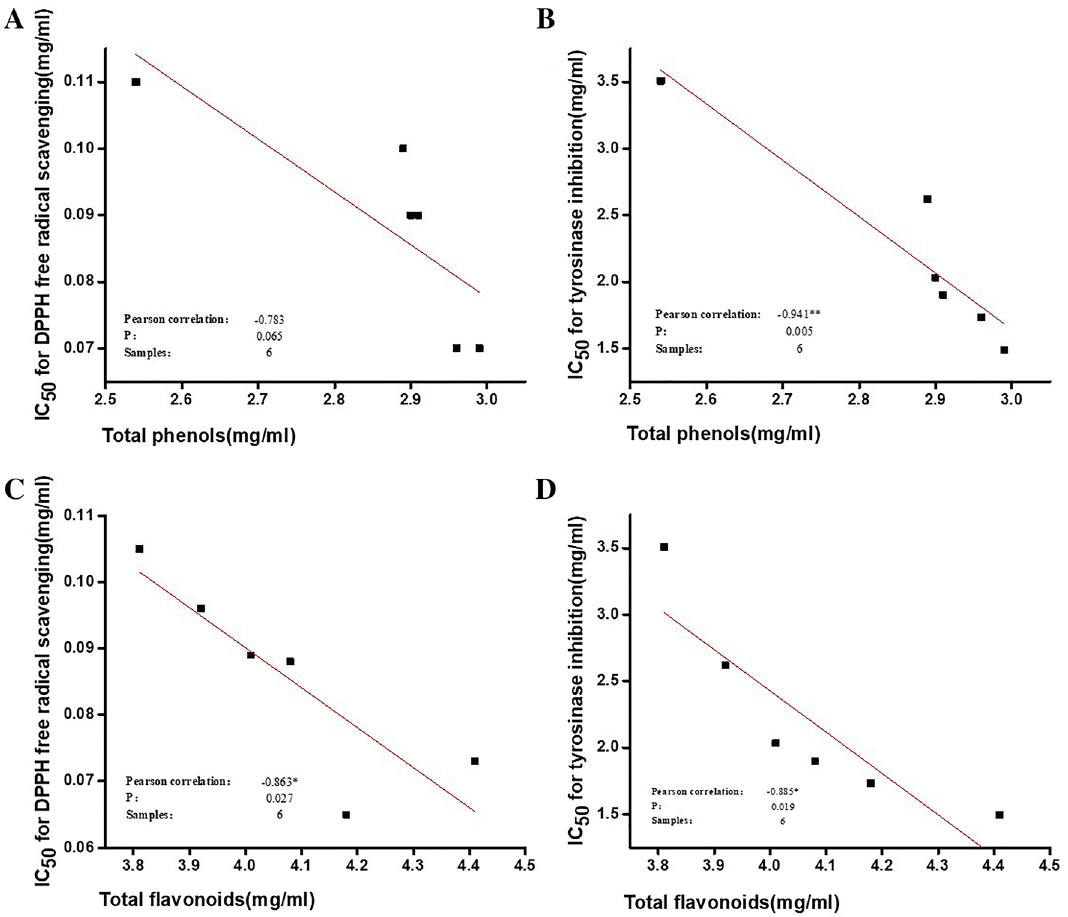
Figure 4. Correlation analysis. ( A ) DPPH radical scavenging activity and total phenolic content, ( B ) tyrosinase inhibition activity and total phenolic content, ( C ) DPPH radical scavenging activity and total flavonoid content, and ( D ) tyrosinase inhibition activity and total flavonoid